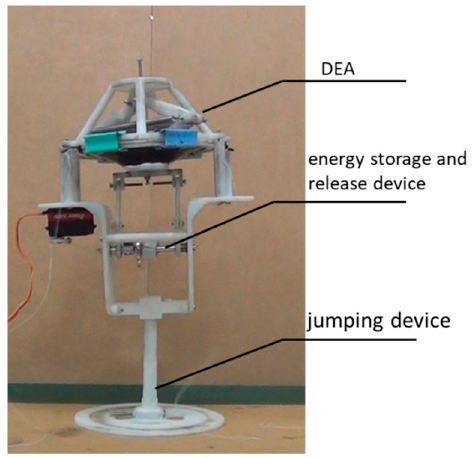
Figure 11. The overall prototype of the jumping robot.